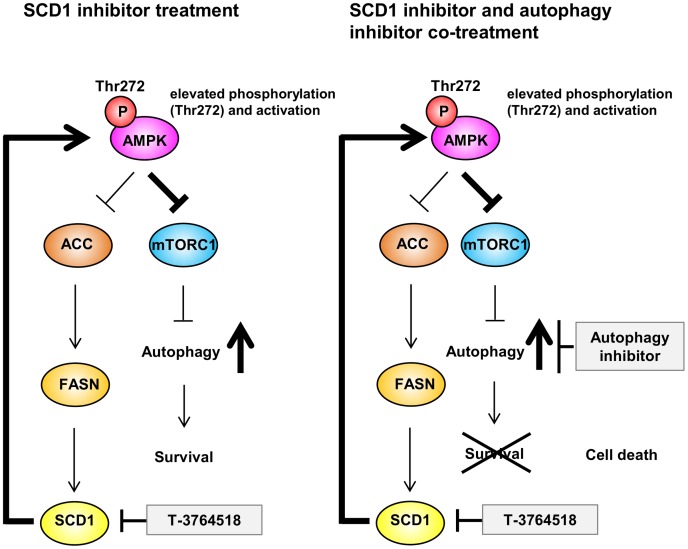
Growth inhibition mode of action (MOA) summary for T-3764518.Autophagy activation functions as a survival signal in cells treated with T-3764518. Dual inhibition of SCD1 and autophagy may be an effective strategy to combat cancer.